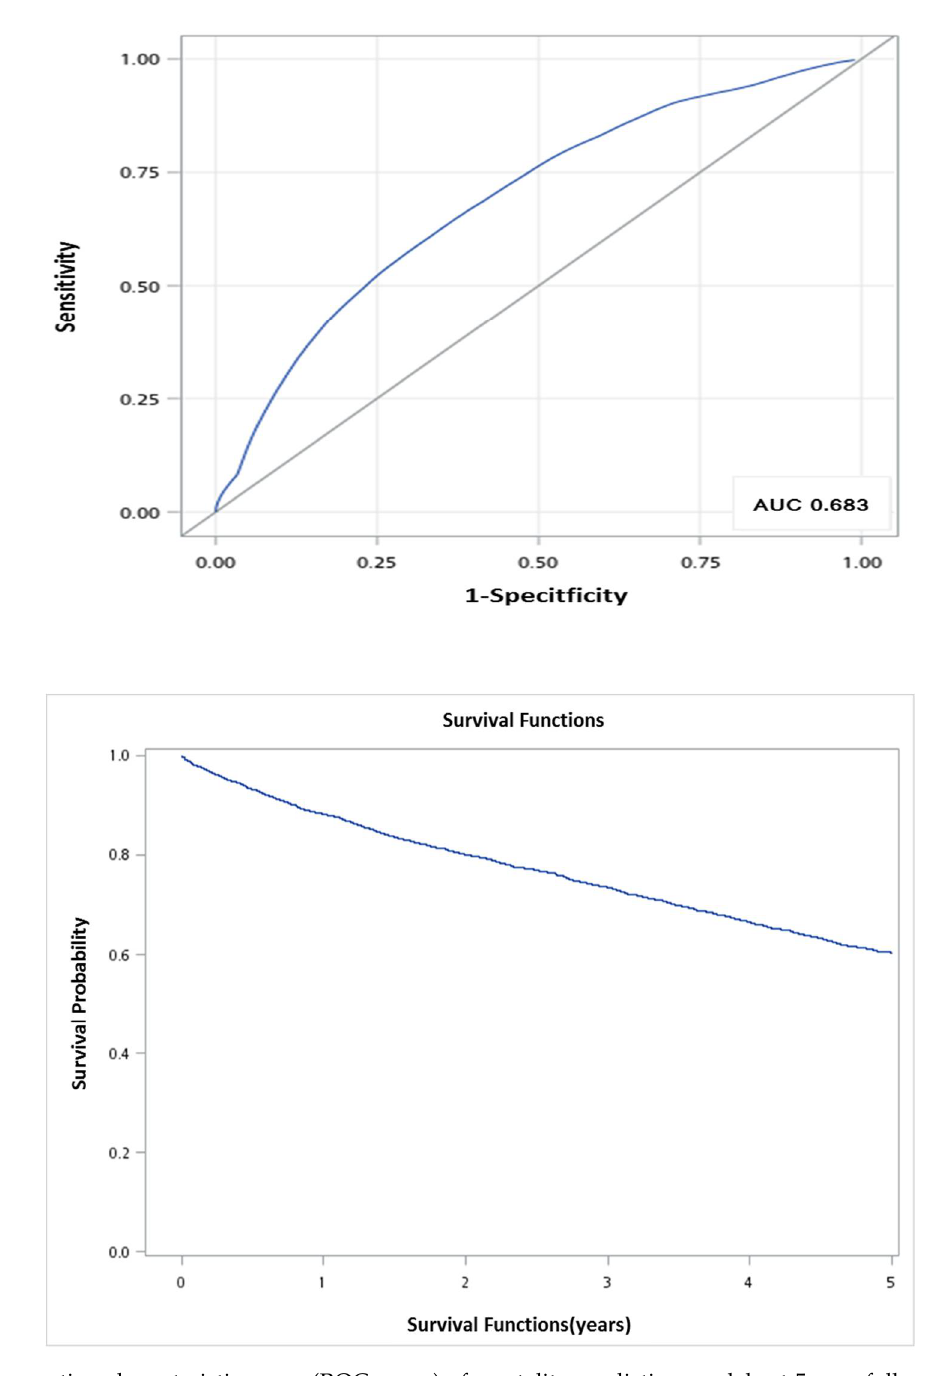
Figure 2. ( A ) Receiver operating characteristic curve (ROC curve) of mortality prediction models at 5-year follow up, including sex, age, and CCI (continuous variable). ( B ) 5-year overall survival rate following schizophrenia.